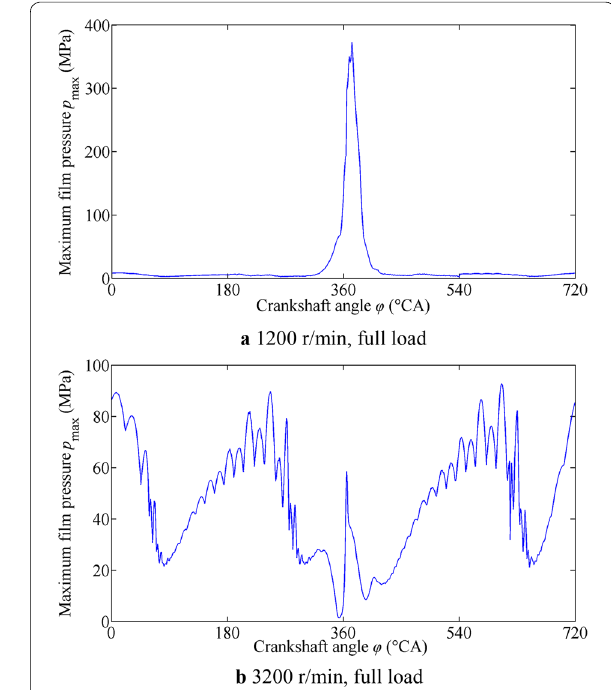
Figure 7 Maximum oil film pressure of connecting-rod bearing